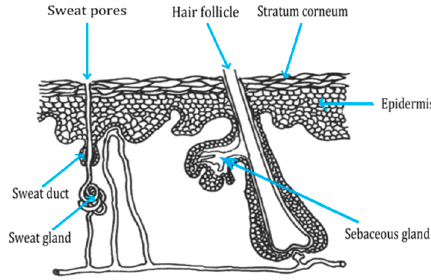
Figure 1. Schematic representation of three pathways for peptide penetration onto the skin. Adapted from [30].